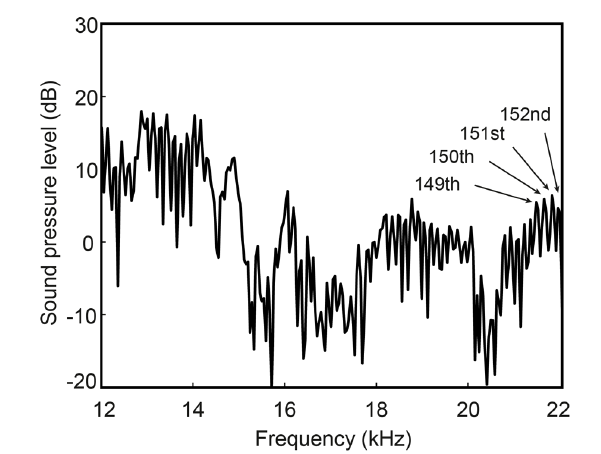
FIGURE 3 | High-frequency spectrum of the spoken vowel /e/ from one male subject (taken from the word “say”). Harmonic energy is measurable beyond the 150th harmonic at nearly 22 kHz (indicated by labeled